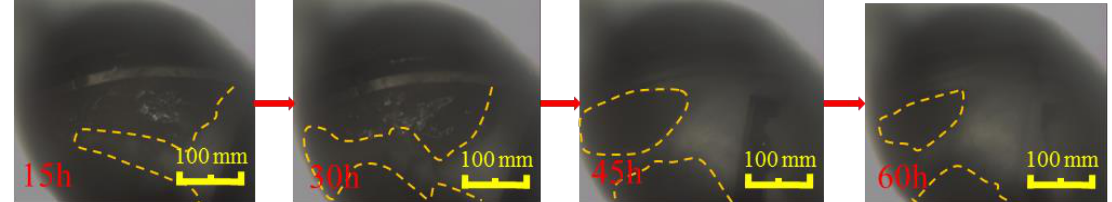
Figure 7. The preparation process of natural gas hydrate in spray method. The yellow dotted line indicates the hydrate boundary. ( a )In the first panel, The white flocculent is hydrate. The area of darker color in contact with hydrate is the prepared water. The black bar is the stirring blade. The round bright iron plate is a fixed arc of the stirring blade. ( b )In the second panel, The white flocculent is hydrate. The area of darker color in contact with hydrate is the prepared water. The black bar is the stirring blade. The round bright iron plate is a fixed arc of the stirring blade. ( c )In the third panel, The white flocculent is hydrate. The area of darker color in contact with hydrate is the prepared water. The black bar is the stirring blade. The round bright iron plate is a fixed arc of the stirring blade. ( d )In the fourth panel, The white flocculent is hydrate. The area of darker color in contact with hydrate is the prepared water.